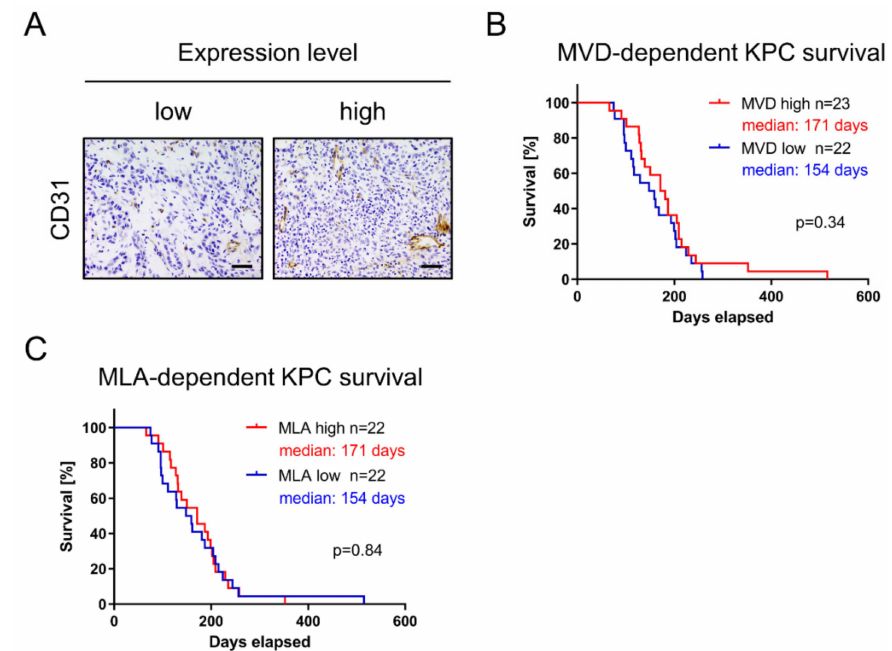
Figure 5. KPC survival not dependent on tumor vascularity. ( A ) IHC for CD31 performed to evaluate tumor vascularization. Scale equals 50 µ m. Vascularity and compression of tumor vessels were investigated by scrutinizing ( B ) MVD and ( C )